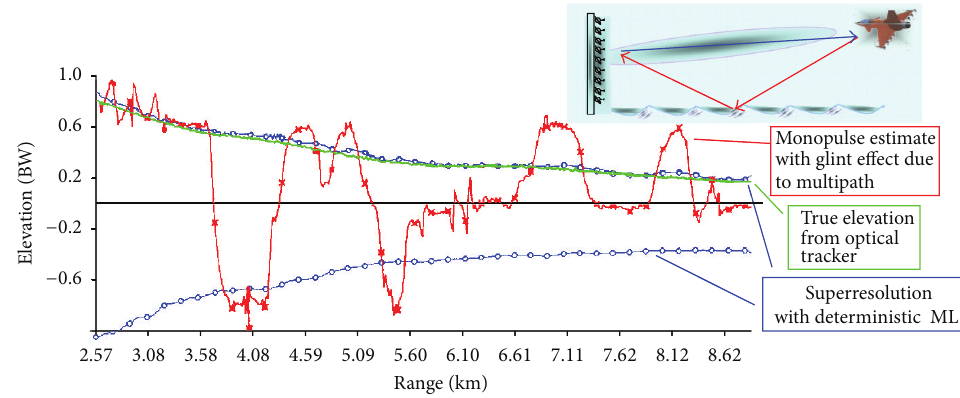
Figure 10: Superresolution of multipath propagation over sea with deterministic ML method (real data from vertical linear array with 32 elements, scenario illustrated above).